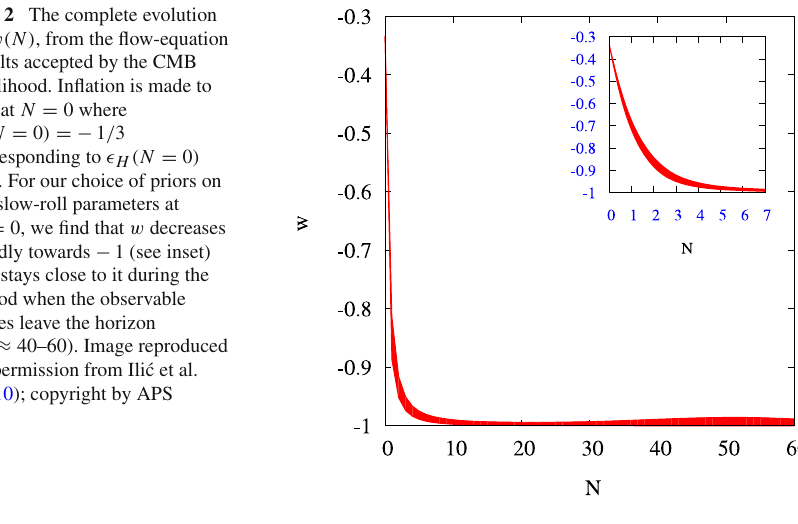
Fig. 2 The complete evolution of w( N ) , from the flow-equation results accepted by the CMB likelihood. Inflation is made to end at N = 0 where w( N = 0 ) = − 1 / 3 corresponding to (cid:30) H ( N = 0 ) = 1. For our choice of priors on the slow-roll parameters at N = 0, we find that w decreases rapidly towards − 1 (see inset) and stays close to it during the period when the observable scales leave the horizon ( N ≈ 40–60). Image reproduced by permission from Ili´c et al. (2010); copyright by